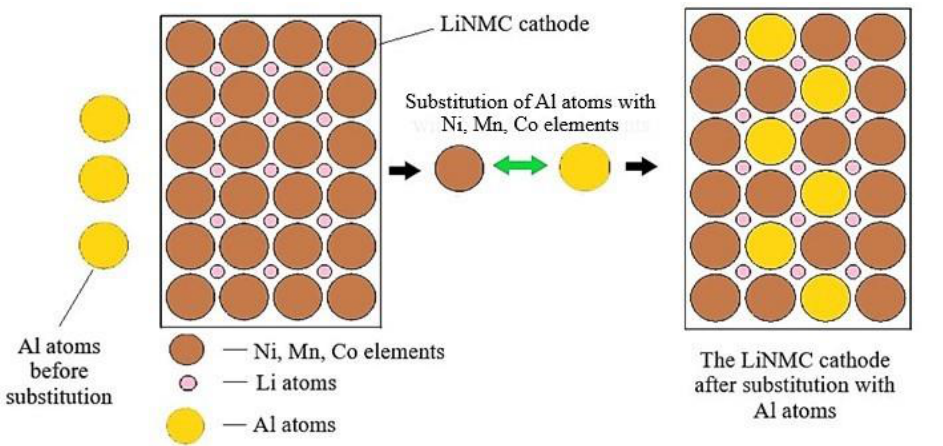
Figure 15. Surface coating in the cathode.